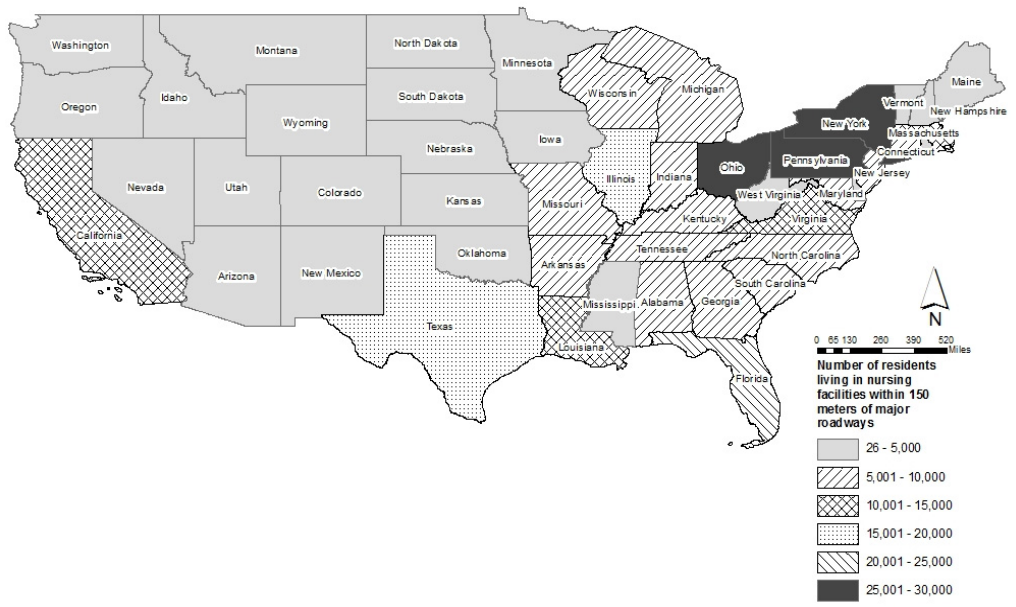
Figure 1. Number of residents living in nursing facilities located near (within 150 m of) major roadways (A1 or A2) in the 48 contiguous U.S. states.